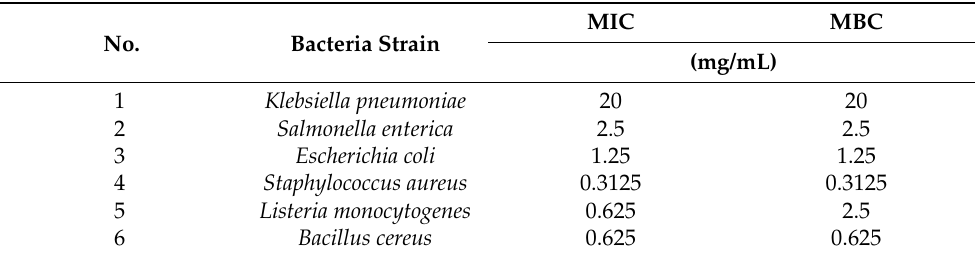
Table 3. Antimicrobial activity of tested J . regia flower extract against Gram-positive and Gram- negative